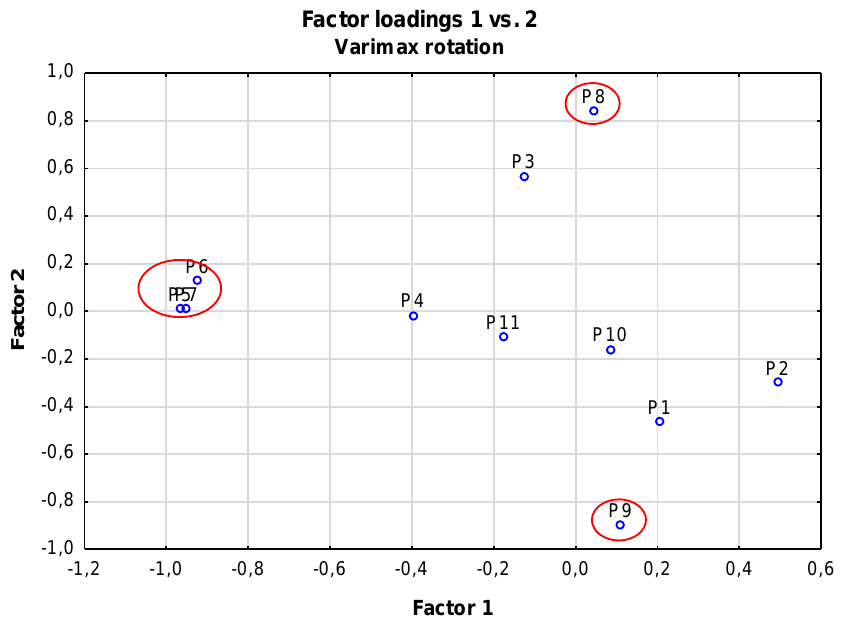
Figure 2. Classification of principal components for questions P1–P11. In fact, P10 is under the plane, and P22 is above the plane of the drawing. Table 1. Factor loadings of principal components for questions P1 – P11 to assess function performance (F1 – 3).